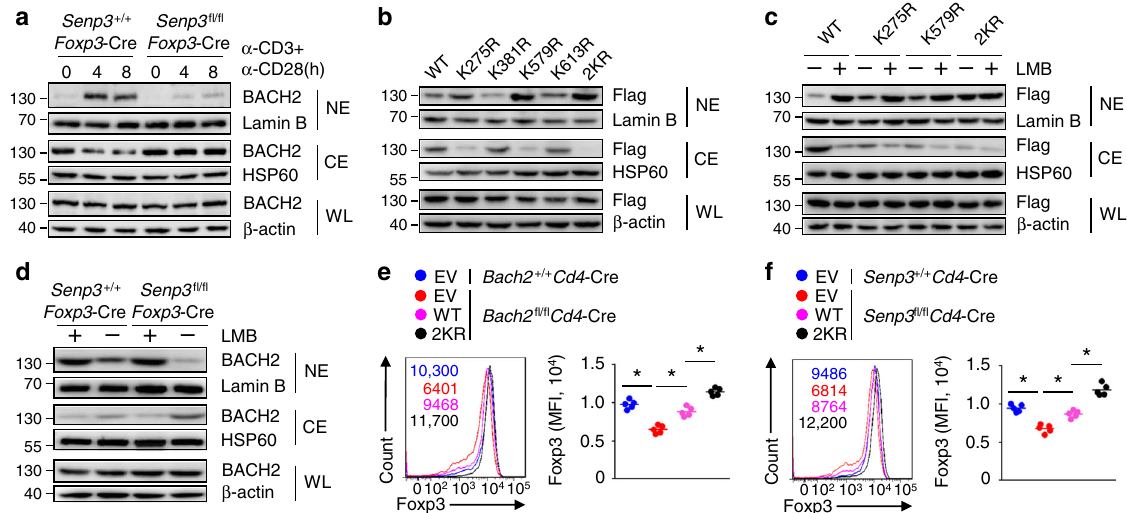
Fig. 6 BACH2 deSUMOylation regulates its nuclear export in Treg cells. a IB analysis of the indicated proteins in whole (WL), nuclear (NE), and cytoplasmic (CE) extracts of Senp3 + / + Foxp3 -Cre and Senp3 fl / fl Foxp3 -Cre Treg cells stimulated with anti-CD3 and anti-CD28 antibodies for 0, 4 or 8 h. b IB analysis of the indicated proteins in anti-CD3 and anti-CD28 antibody-stimulated naive CD4 + T cells from Bach2 fl / fl Cd4 -Cre mice transduced with the indicated lentiviral vector encoding Flag-WT BACH2 or Flag-mutant BACH2 under Treg cell conditions. c IB analysis of the indicated proteins in different lentivirus-transduced BACH2-de fi cient CD4 + T cells under Treg cell conditions treated with 10 ng/ml of leptomycin B for 4 h. d IB analysis of Senp3 + / + Foxp3 -Cre and Senp3 fl / fl Foxp3 -Cre splenic Treg cells stimulated with anti-CD3 and anti-CD28 antibodies in the presence of leptomycin B for 4 h. e Splenic Treg cells (CD4 + CD25 + GFP + ) from Rag1 − / − mice reconstituted (for 8 weeks) with Bach2 + / + Cd4 -Cre or Bach2 fl / fl Cd4 -Cre bone marrow (BM) cells transduced with empty vector (EV) or vector expressing WT or 2KR BACH2 were stimulated with anti-CD3 and anti-CD28 antibodies for 24 h and subjected to fl ow cytometric analysis of Foxp3 expression. f Splenic Treg cells from Rag1 − / − mice reconstituted with Senp3 + / + Cd4 -Cre or Senp3 fl / fl Cd4 - Cre BM cells transduced with EV, WT or 2KR BACH2 were stimulated with anti-CD3 and anti-CD28 antibodies for 24 h and subjected to fl ow cytometric analysis of Foxp3 expression. Numbers above graphs indicate MFI of Foxp3 ( e , f ). Data shown are representative of three independent experiments. Error bars are the mean ± SEM values ( e , f ). Two-tailed unpaired Student ’ s t tests were performed ( e , f ). * P <